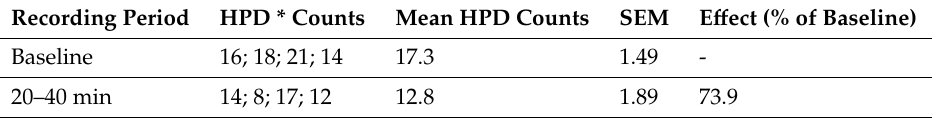
Table 5. Results of mesial temporal lobe epilepsy model (MTLE) for KM-568 tested at 114 mg / kg ( i.p .). Recording